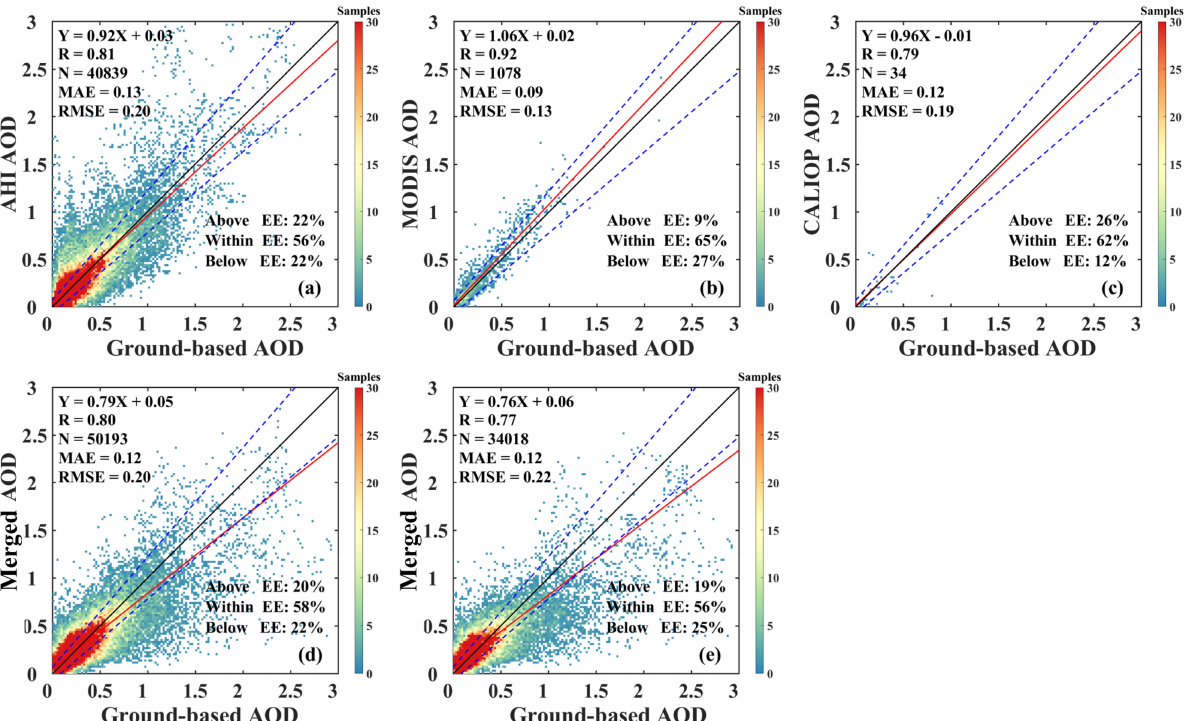
Figure 7. Validation results of the ( a ) original Himawari-8 L2 AHI, ( b ) MODIS, ( c ) CALIOP, ( d ) merged AODs, and ( e ) merged AODs s for areas where the initial Himawari-8 AHI, MODIS, and CALIOP AODs are all missing with AERONET and MAN AODs as benchmarks. The black, blue, and red lines represent the 1:1 reference, EE envelop, and regression lines of the AOD matchups,